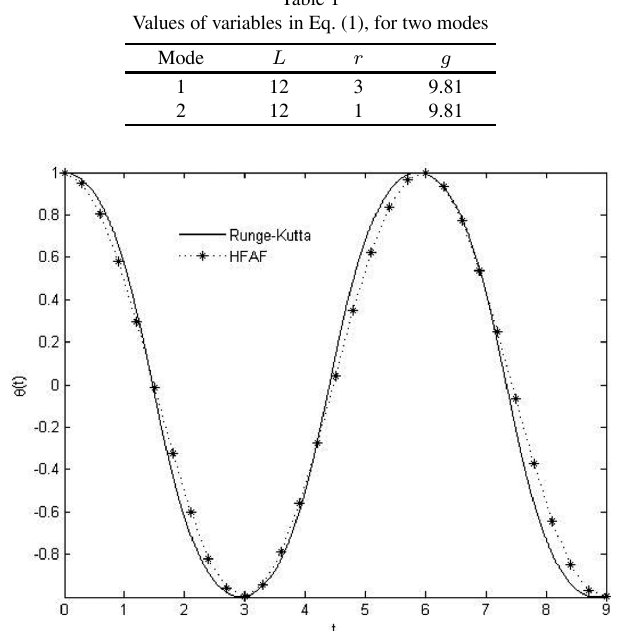
Table 1 Values of variables in Eq. (1), for two modes